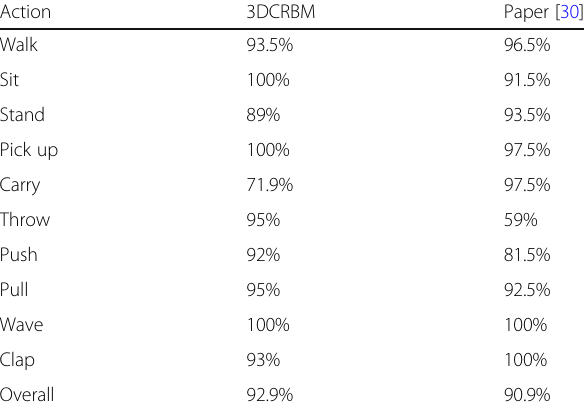
Table 2 Comparison of